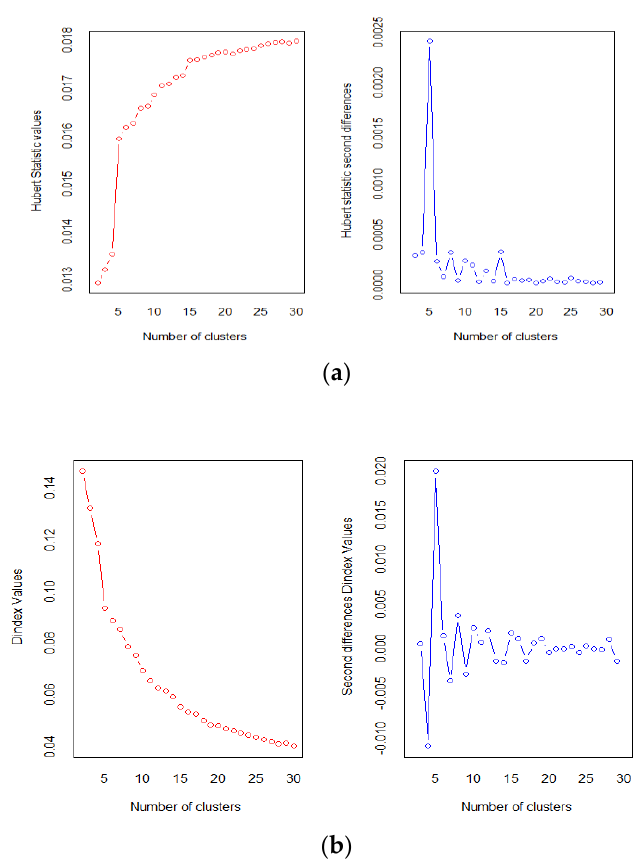
Figure 5. Examination methods to determine the number of clusters by ( a ) the Hubert index and ( b ) DI index.